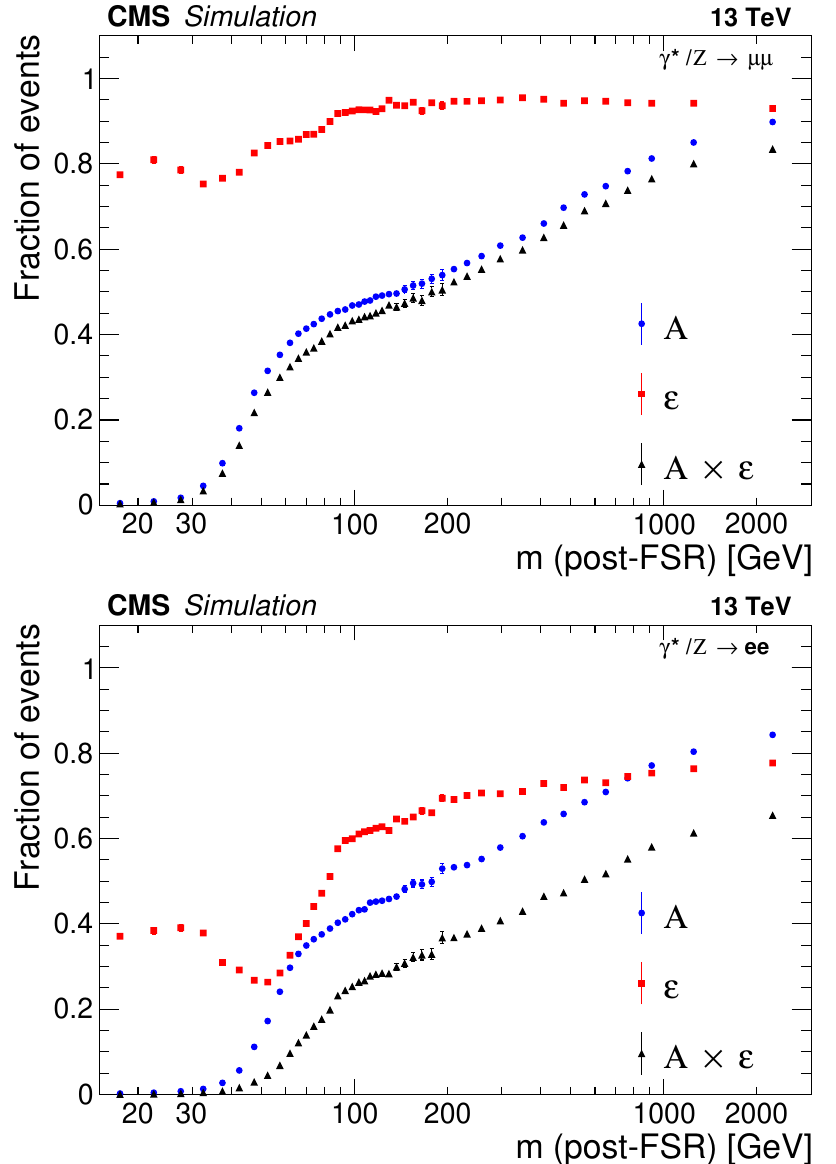
Figure 2 . The signal acceptance (A), e(cid:14)ciency ( " ) and their product for each invariant mass bin in the dimuon (top) and dielectron (bottom) channels, calculated from simulation. The error bars on the data points represent the statistical uncertainty only.